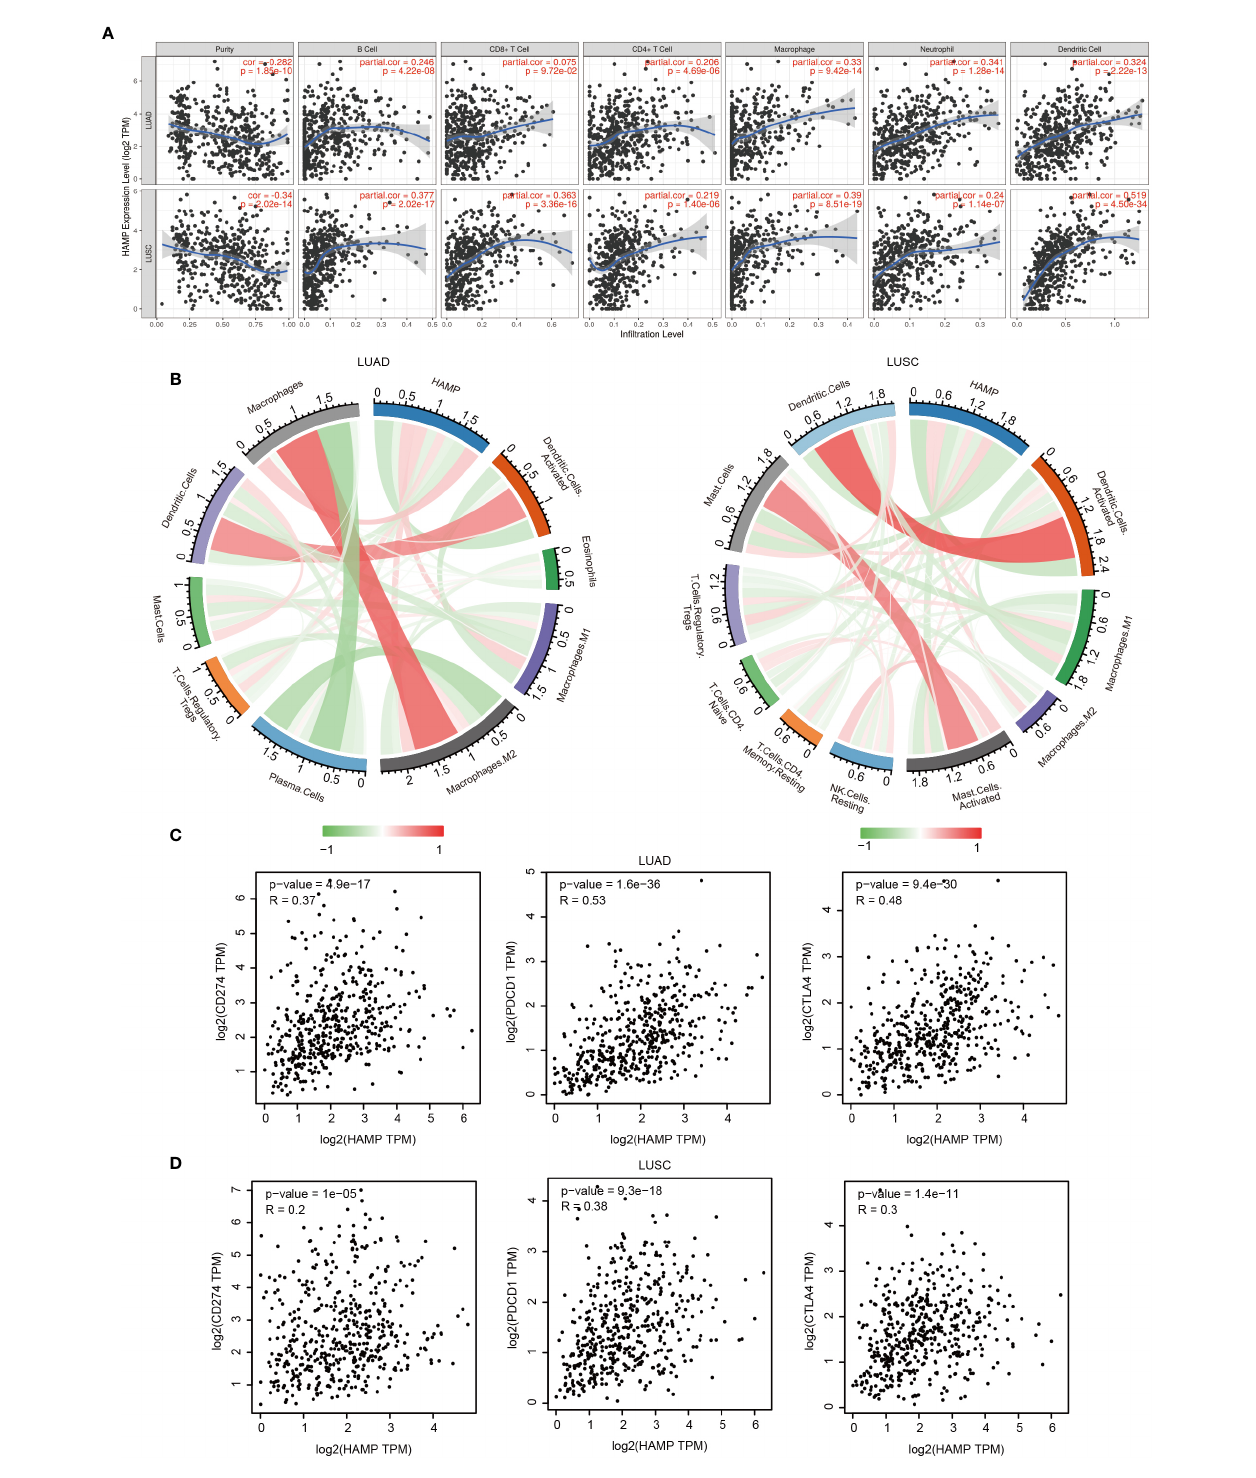
FIGURE 7 | Correlation of hepcidin expression with immune in fi ltration level. (A) Hepcidin is signi fi cantly associated with tumor purity and is positively correlated with the in fi ltration of different immune cells using the TIMER database. (B) Hepcidin expression has a signi fi cant correlation with the in fi ltration of immune cells in lung cancer using the CIBERSORT algorithm. (C, D) Scatterplots of the correlations between hepcidin expression and PD-1, PD-L1 and CTLA-4 in LUAD and LUSC using the GEPIA